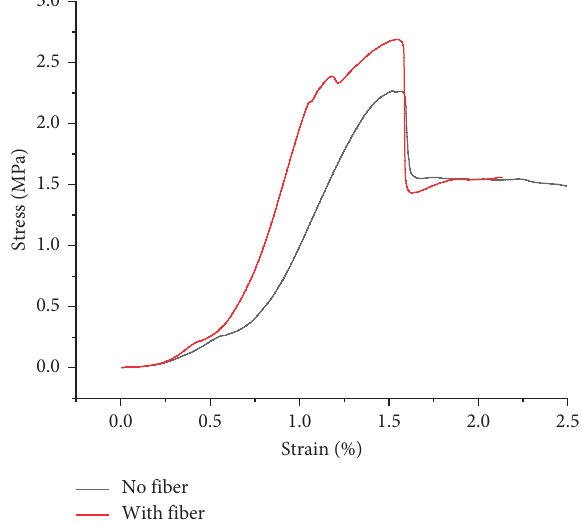
Figure 18: The stress-strain curves of the test pieces.